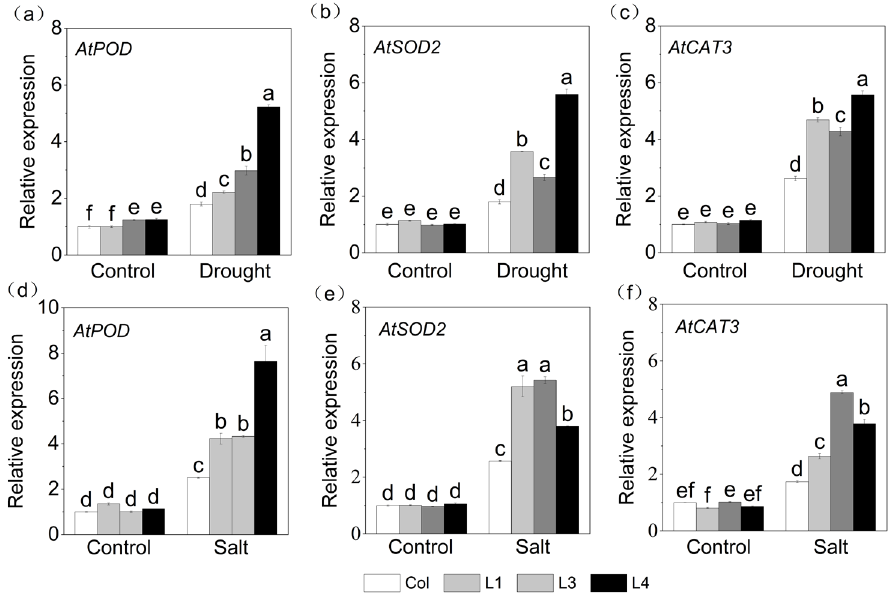
Fig. 7: Expression of antioxidant enzyme-related genes in transgenic and wild-type A. thaliana lines under drought and salt stress.